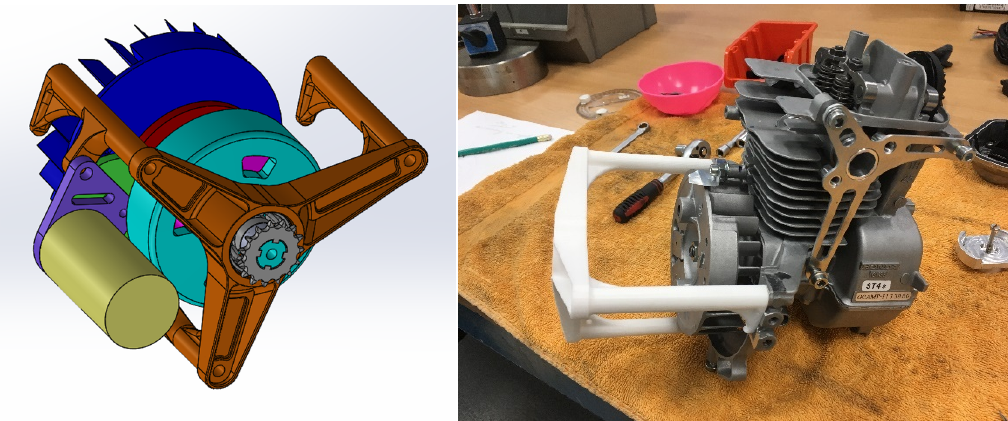
Figure 12. Verification of placing the starting system using 3D printing.